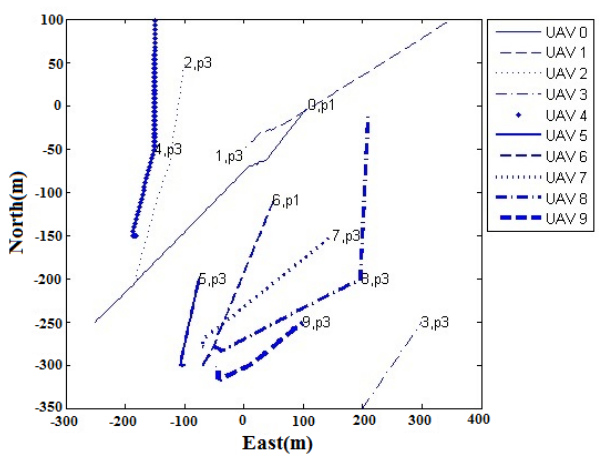
Figure 16. Case 3: Cooperative collision avoidance against temporary communication failure (normal situation): UAVs 1 and 0 perform collision avoidance.